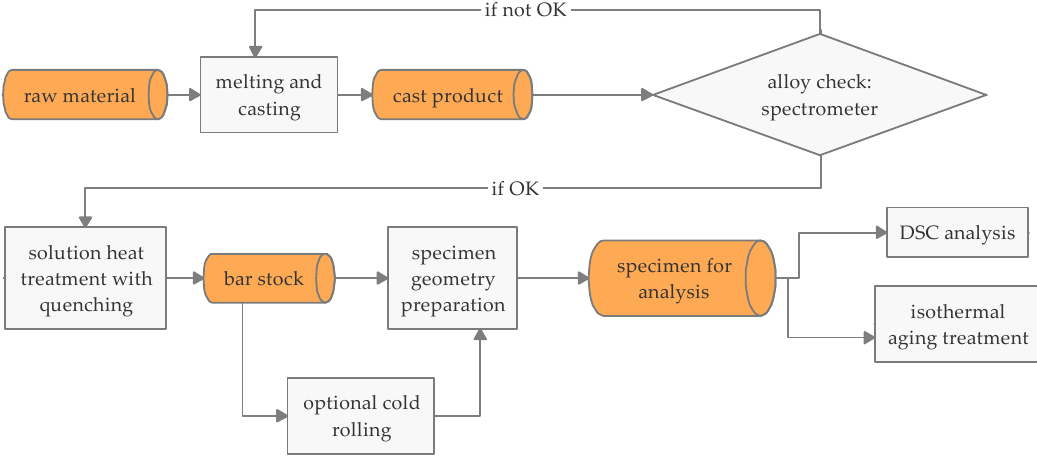
Figure 1. Schematic of the process of specimen preparation and heat treatment. During isothermal aging experiments (for hardness and electrical conductivity mea- surements), the specimens were aged up to 48 h at 350 ◦ C, 375 ◦ C, 400 ◦ C, 425 ◦ C, 450 ◦ C, and 500 ◦ C (Figure 2). Measurements of electrical conductivity were conducted with an eddy current test (Sigmascope SMP10, with TF100A for temperature compensation, Helmut Fischer GmbH, Sindelfingen, Germany) and hardness tests with a microhardness tester (HV 0.1 ) ((NEXUS 412A equipped for DIN EN ISO 6507-1:2018 Vickers hardness test, Inno- vatest GmbH, Selfkant-Heilder, Germany). Due to the huge amount of experimental data, only the peak values are visualized. Each data point (red) on the corresponding surface plots is based on the peak of an isothermal aging curve. The average standard derivation for electrical conductivity measurements was 0.83 MS/m (n = 7) and 5.18 HV 0.1 (n = 5) for hardness